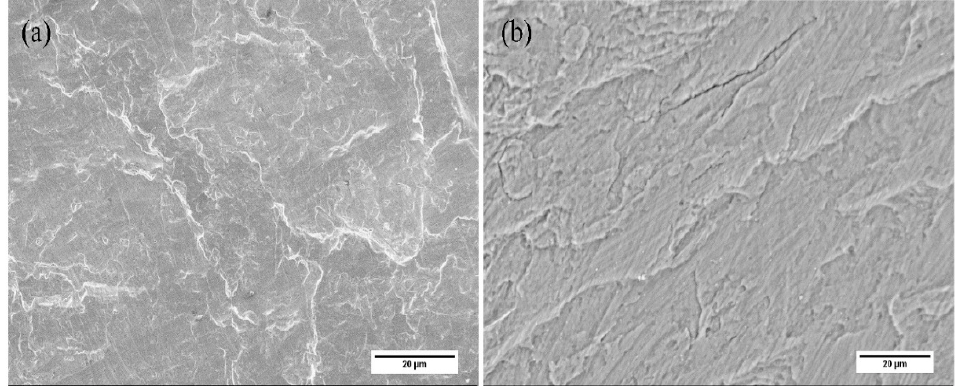
Figure 10. SEM microphotographs of worn surface of composite samples after ( a ) Step #1 and ( b ) Step #8.